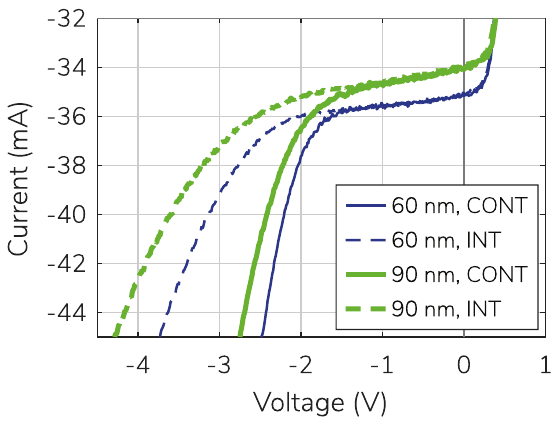
Fig. 4. Reverse IV characteristics for samples with two different thicknesses of the CdS buffer layer for continuous (solid lines) and intermittent (dashed lines) voltage sweeps. Average data of three samples per thickness are